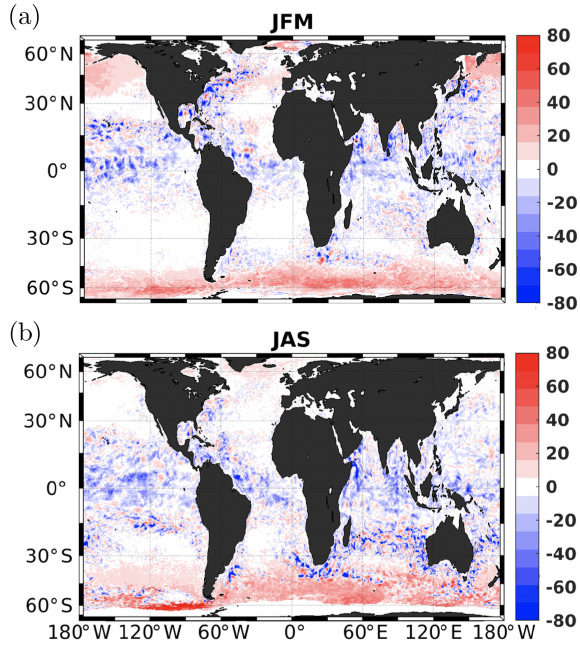
Figure 8. (a, b) Seasonally averaged MLD differences (All_CPL2- No_CPL) relative to the uncoupled simulation No_CPL. Red corre- sponds to a deeper MLD for All_CPL2.